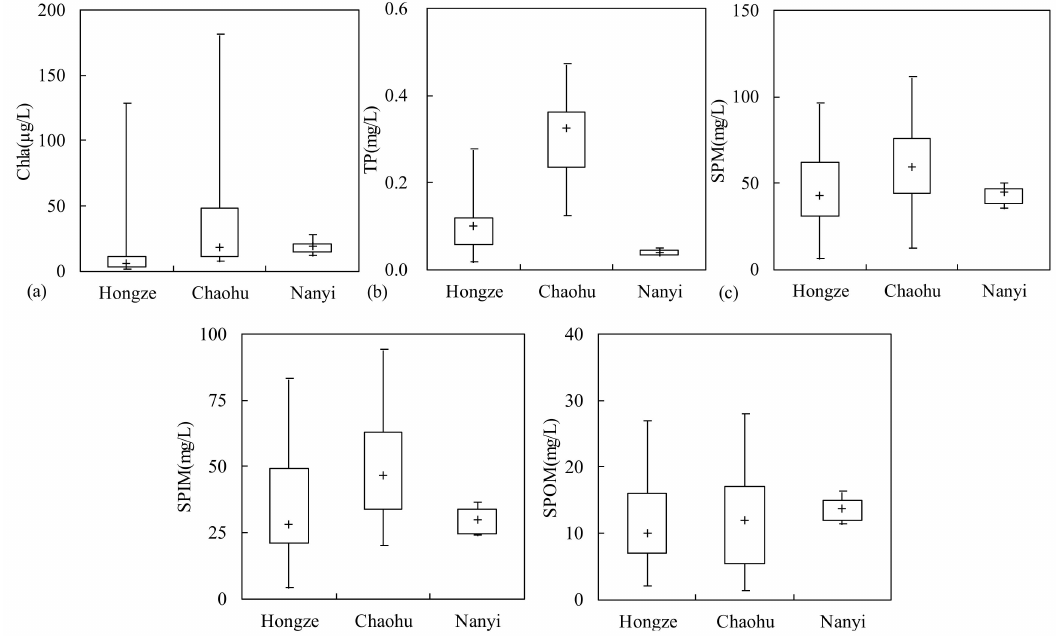
Figure 7. Box-plot of the water quality attributes of the three lakes: ( a ) Chla; ( b ) TP; ( c ) SPM; ( d ) SPIM; ( e )